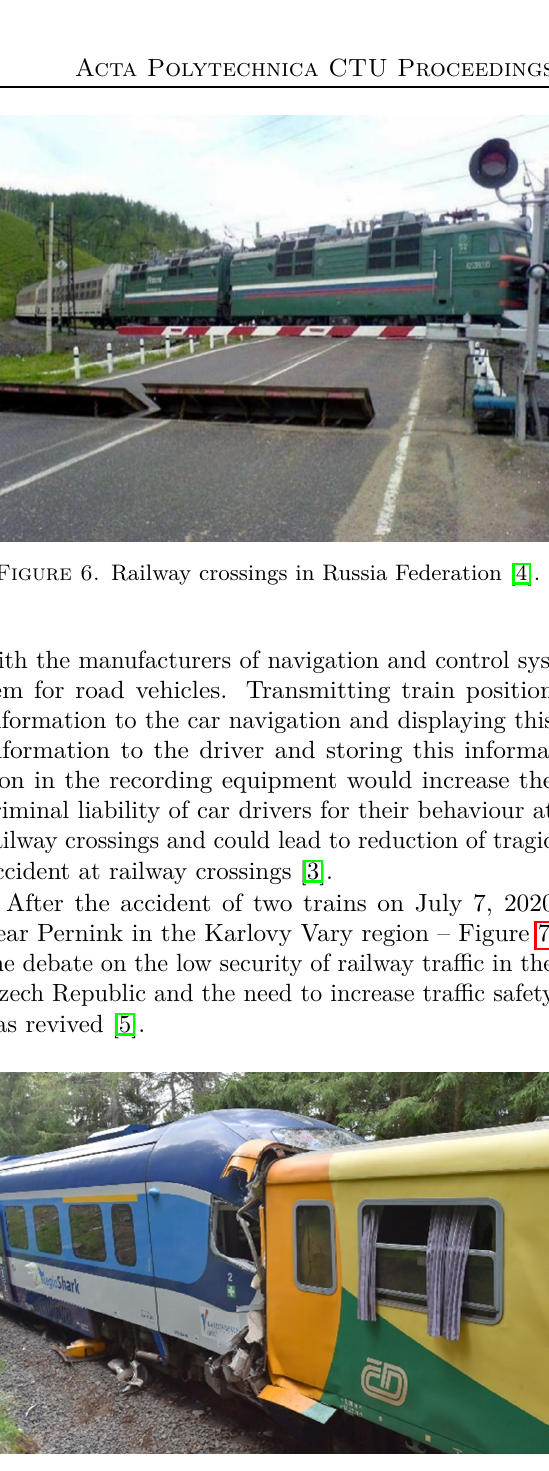
Figure 7. Train accident near Pernink